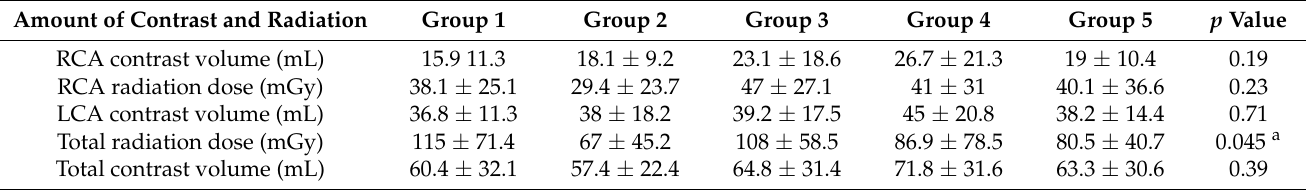
Table 3. Summary of contrast volume and radiation dose during the procedure in all